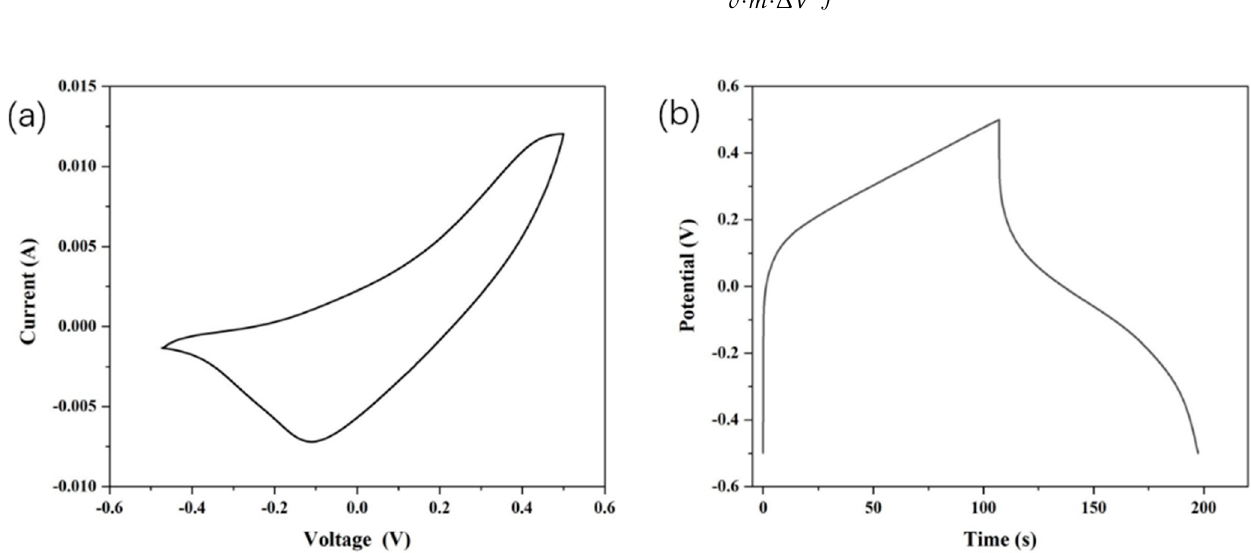
Figure 7. PANI: ( a ) cyclic voltammetry (CV) profile at the scan rate of 5 mV/s, ( b ) galvanostatic charge-discharge (GCD) profile at the current density of 1 A/g.